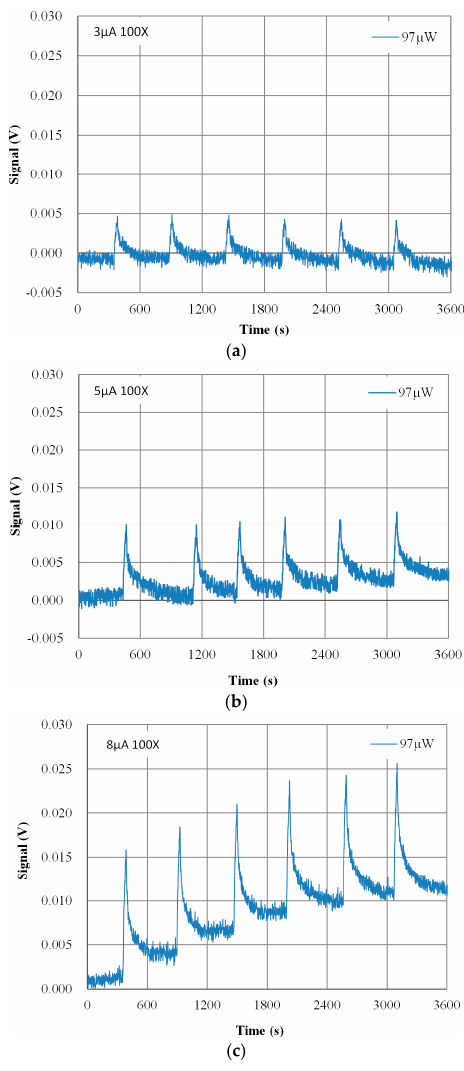
Figure 7. Three observed heat pulse response curves of the proposed multichannel calorimetric simultaneous assay platform under test loop currents of ( a ) 3; ( b ) 5; ( c ) 8 µA.